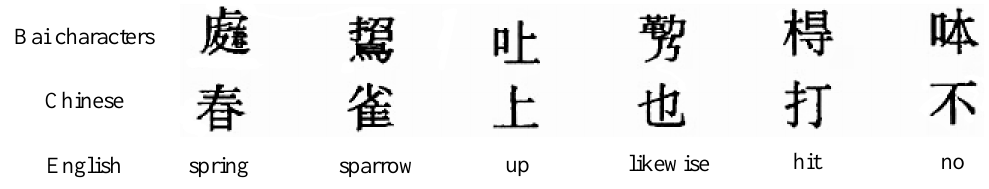
Figure 5. Excerpts of Chinese and Bai